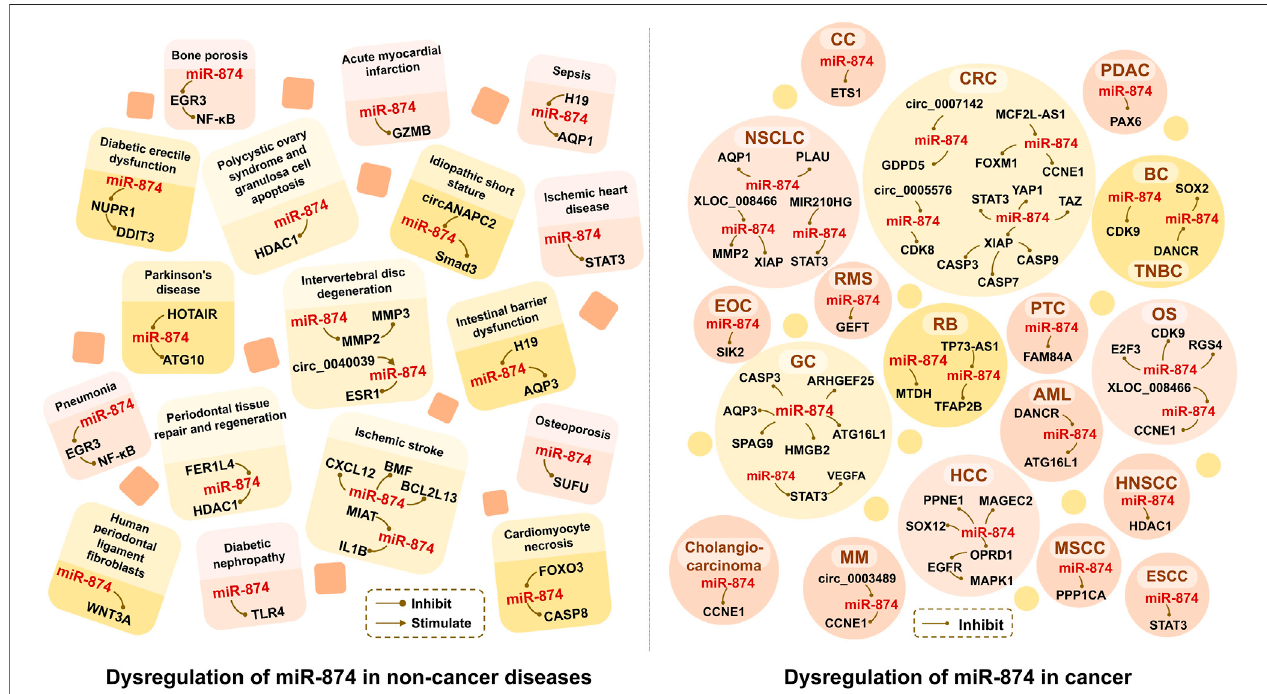
FIGURE 1 | Dysregulation of miR-874 in human cancer and non-cancer diseases. HCC, Hepatocellular carcinoma; PDAC, Pancreatic ductal adenocarcinoma; NSCLC,Non-smallcelllungcancer;OS,Osteosarcoma; EOC,Epithelialovariancancer;CC,Cervicalcancer;TNBC,Triplenegativebreastcancer;rBC,Breastcancer; CRC, Colorectal cancer; ESCC, Esophageal squamous cell Squamous cell carcinoma; MSCC, Maxillary sinus squamous cell carcinoma; RB, Retinoblastoma; GC, Gastric cancer; RMS, Rhabdomyosarcoma; PTC, Papillary thyroid carcinoma; MM, myeloma; AML, acute myeloid leukemia; HNSCC, head and neck squamous cell